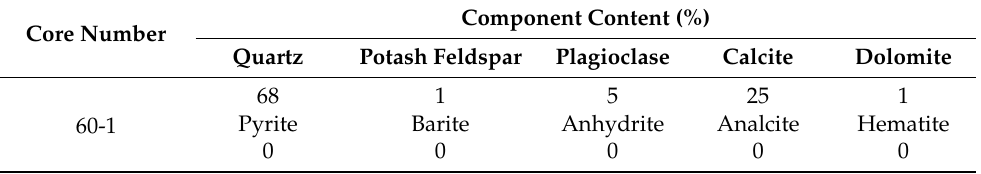
Table 3. X-ray diffraction test results